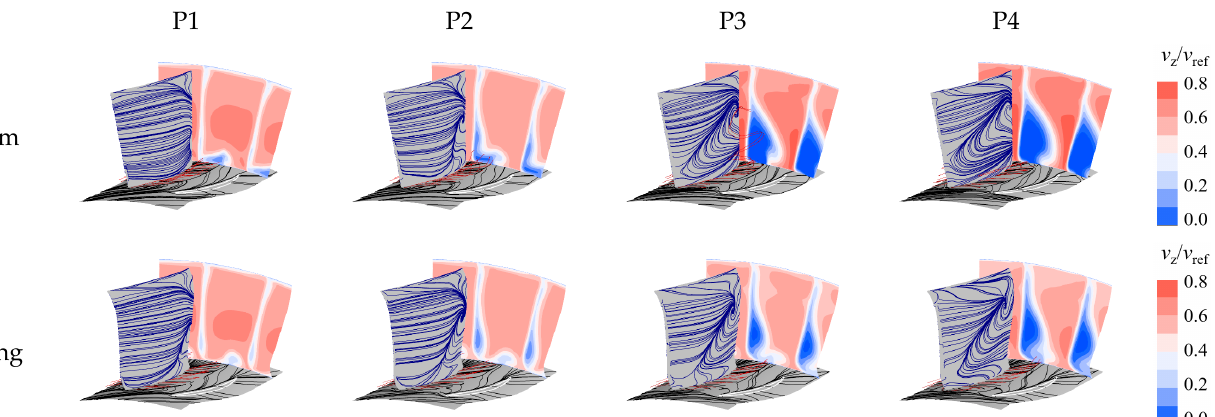
Figure 28. The comparison of field distribution between the datum and the redesigned stator.